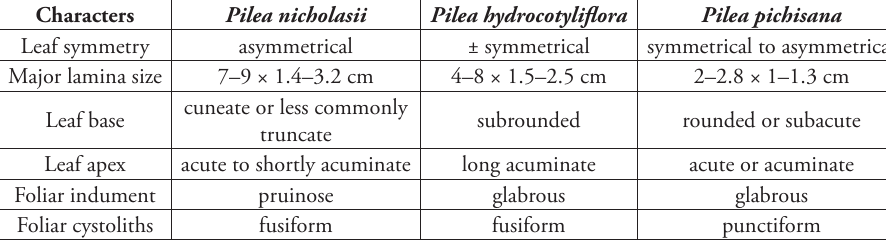
Table 3. Diagnostic characters that distinguish Pilea nicholasii and two similar species.